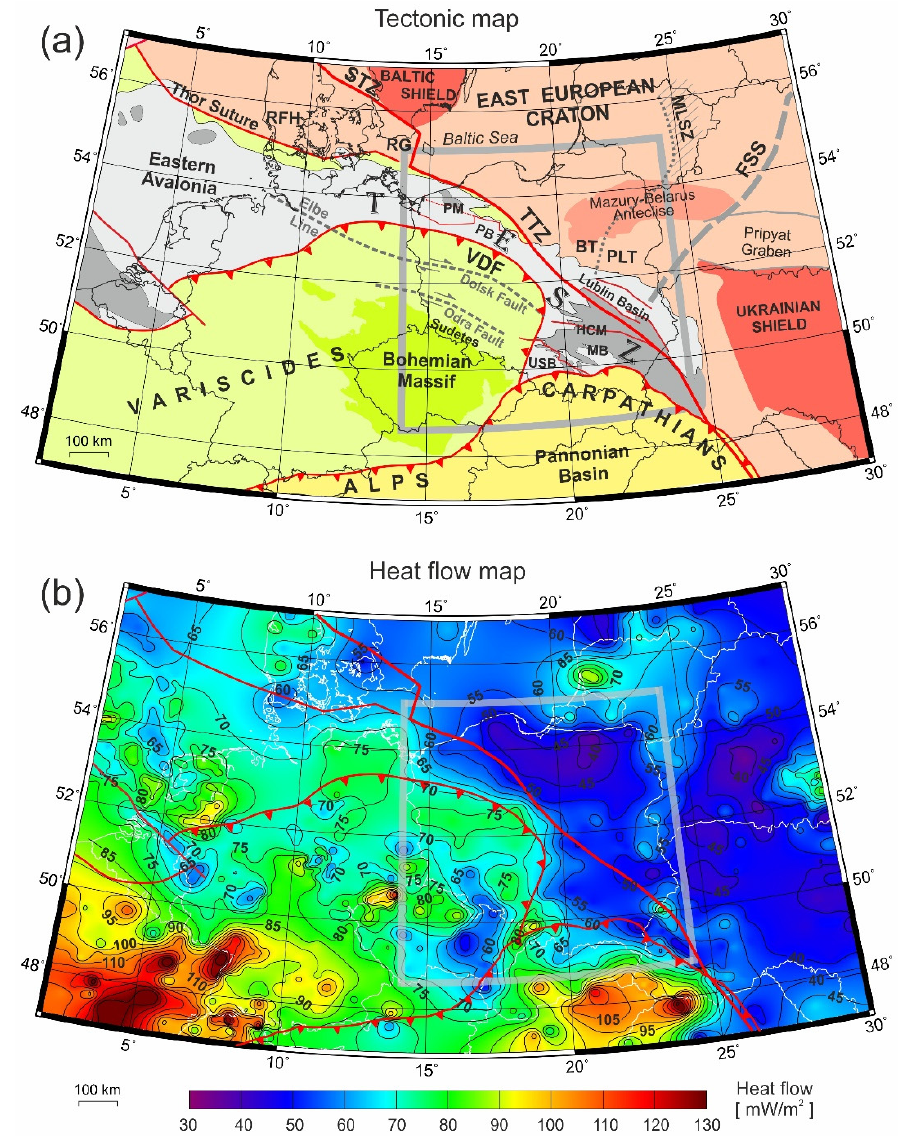
Figure 10. Tectonics and heat flow. ( a ) Tectonic sketch of the pre-Permian Central Europe in the contact of the East European Craton, Variscan and Alpine orogens compiled by Grad et al., 2016 [7,48] and Narkiewicz et al. (2011 [38]) is redrafted/modified from Majorowicz et al. [18]. BT-Baltic Terrane; FSS—Fennoscandia-Sarmatia Suture; HCM—Holy Cross Mountains; MB—Małopolska Block; MLSZ—Mid-Lithuanian Suture Zone; NEGB—North-Eastern German Basin; PB—Polish Basin; PM—Pomerania Massif; RG—Rønne Graben; RFH—Ringkøbing-Fyn High; STZ—Sorgenfrei- Tornquist Zone; TESZ—Trans-European Suture Zone; TTZ—Teisseyre-Tornquist Zone; USB—Upper Silesian Block; VDF—Variscan Deformation Front. ( b ) Central European heat flow map based on corrected for paleoclimate heat flow data from Majorowicz and Wybraniec [22] with main tectonic lines. Grey frames show the location of the study area.